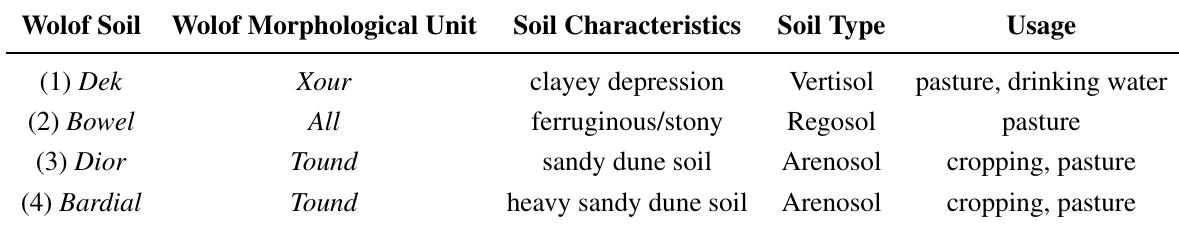
Table 1. Pedological terms and units used in this study.